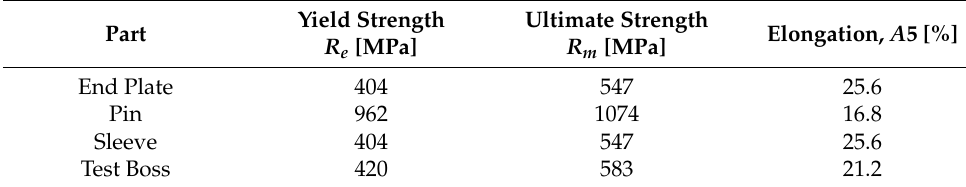
Table 1. Material characteristics of EPS parts.